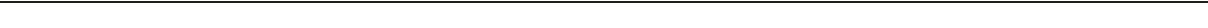
Fig. 1 BRD9 is part of the ESC pluripotency transcriptional regulatory network. a Time course experiment assessing mouse ES cell number after treatment with DMSO or I-BRD9 at either 1.11 or 3.33 µ M. Error bars represent one standard deviation from the mean of biological replicates, n = 9. Two-tailed t -test was performed to obtain the p values. * p < 0.05, ** p < 0.01, *** p < 0.001. b As in a , but for ESCs treated with DMSO or BI-9564 at either 300 nM or 1 µ M; n = 6. c As in a , but for ESCs transduced with shRNA against a scrambled control or Brd9 ; n = 3 for each sh Brd9 experiment. d Scatterplot of average log2 fragments per kilobase of transcript per million mapped reads (FPKM) mRNA expression level in DMSO-treated ESCs against log2 fold change (FC) in expression after 24 or 48 h of 10 µ M I-BRD9 treatment in serum/LIF conditions. Red and blue indicate differential expression increased or decreased by 1.5- fold or more (Benjamin-Hochberg FDR < 0.05), respectively, from two independent biological replicates. e Venn diagram of differentially expressed genes (DEGs) in the 24 and 48 h I-BRD9 RNA-Seq datasets. f Signi fi cance of the I-BRD9 DEG enrichment in each gene ontology process. FDR values were calculated according to Benjamin-Hochberg multiple testing (GSEA). g GSEA enrichment plots of either the signi fi cantly downregulated (left) or upregulated (right) I-BRD9 DEGs using the shcontrol and sh Brd9 RNA-Seq dataset. NES normalized enrichment score, FWER p value familywise error rate calculated using single tail tests on the positive or negative side of the null distribution. h Box plot of the log2 FC in expression upon sh Brd9 knockdown, grouped into quintiles according to the genes ’ log2 FC upon I-BRD9 addition. Shades of blue and red correspond to the degree of log2 FC down- or upregulation in I-BRD9/DMSO. Black bars indicate the mean per quintile. i As in g , GSEA enrichment plot of BRG1-dependent genes in ESCs using the I- BRD9 RNA-Seq dataset. Source data for a – c are provided as Source Data fi